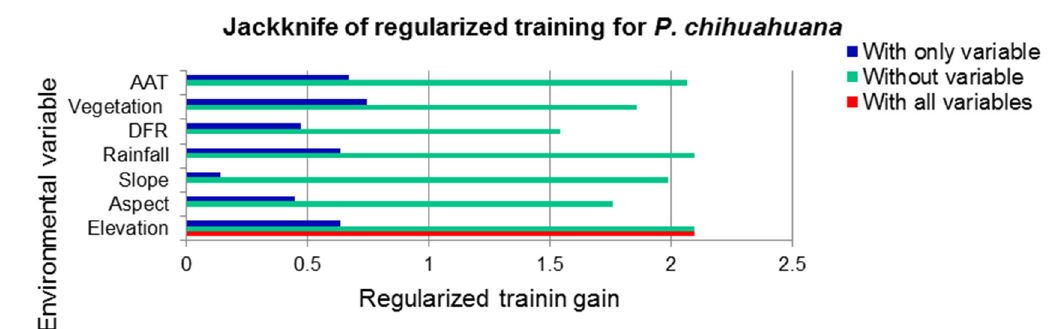
Figure 9. Maps of estimated areas of potential distribution of Picea chihuahuana at local scale using: ( a ) overlay method, ( b ) MaxEnt.